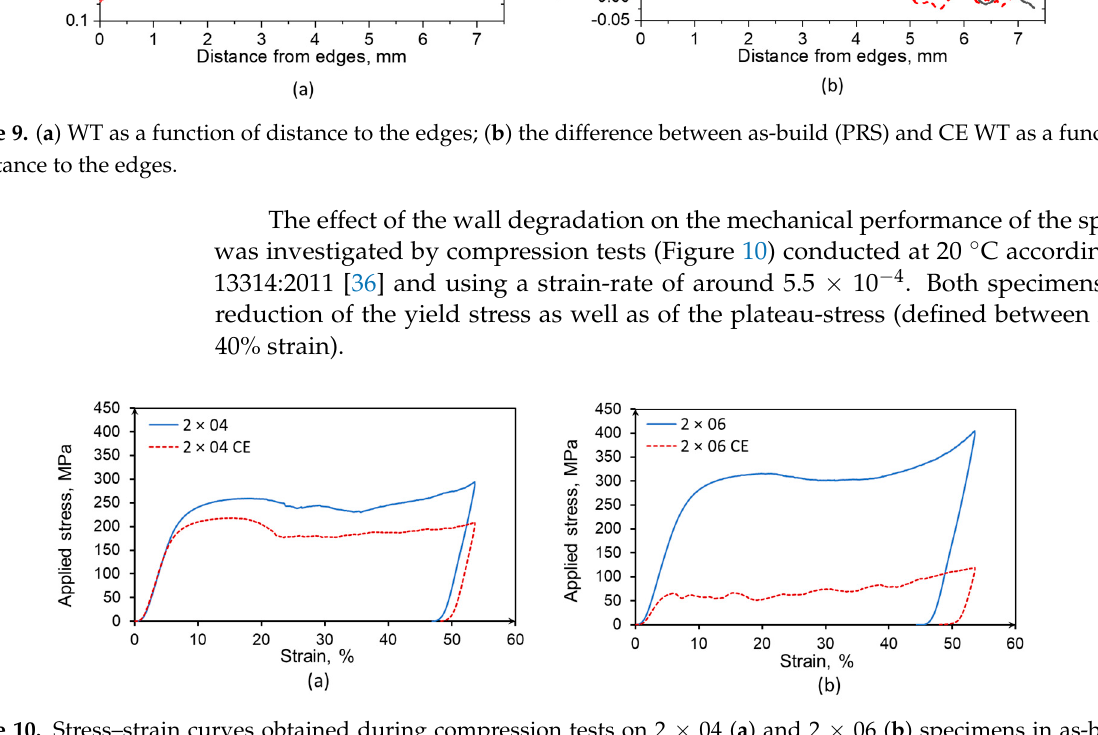
Figure 10. Stress–strain curves obtained during compression tests on 2 × 04 ( a ) and 2 × 06 ( b ) specimens in as-build condition and after CE.